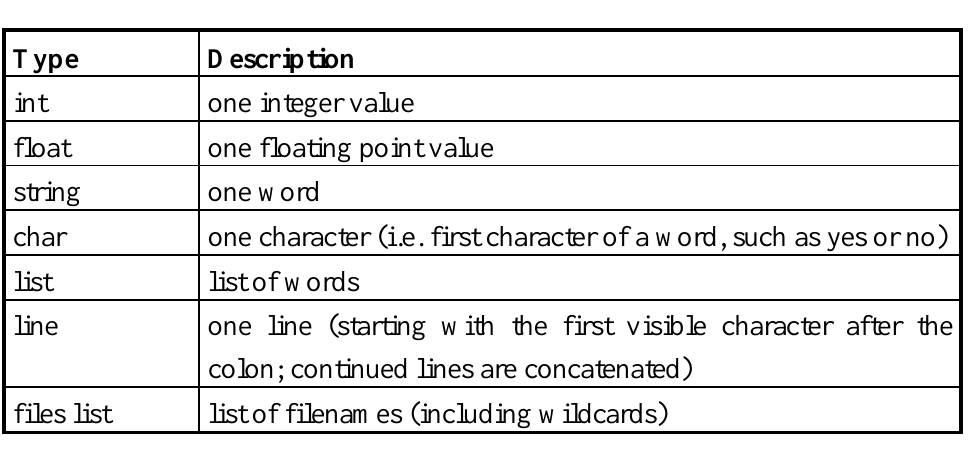
Table 2: List of runtime parameter types used in the input